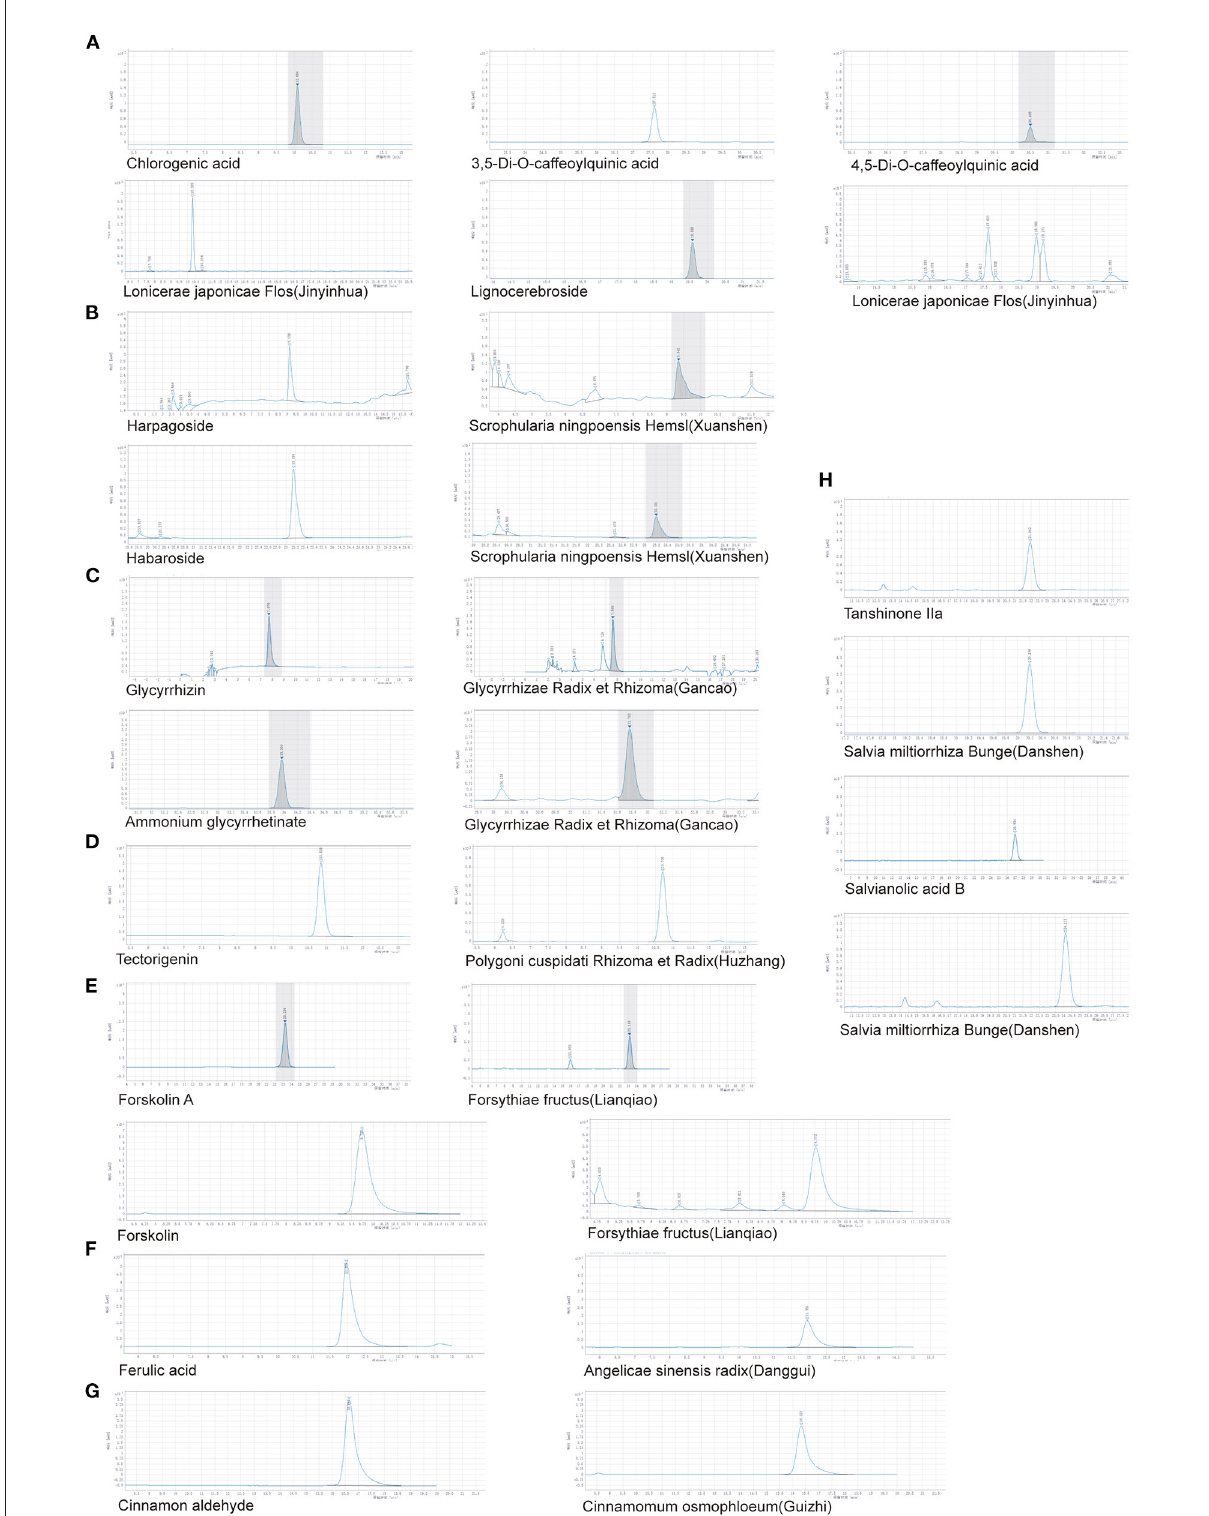
FIGURE2 HPLC determination of major components in different herbs. (A) Lonicerae japonicae flos (Jinyinhua). (B) Scrophularia ningpoensis Hemsl. (Xuanshen). (C) Glycyrrhizae Radix et Rhizoma (Gancao). (D) Polygoni cuspidati Rhizoma et Radix (Huzhang). (E) Forsythiae Fructus (Lianqiao). (F) Angelicae sinensis Radix (Danggui). (G) Cinnamomum osmophloeum (Guizhi). (H) Salvia miltiorrhiza Bunge